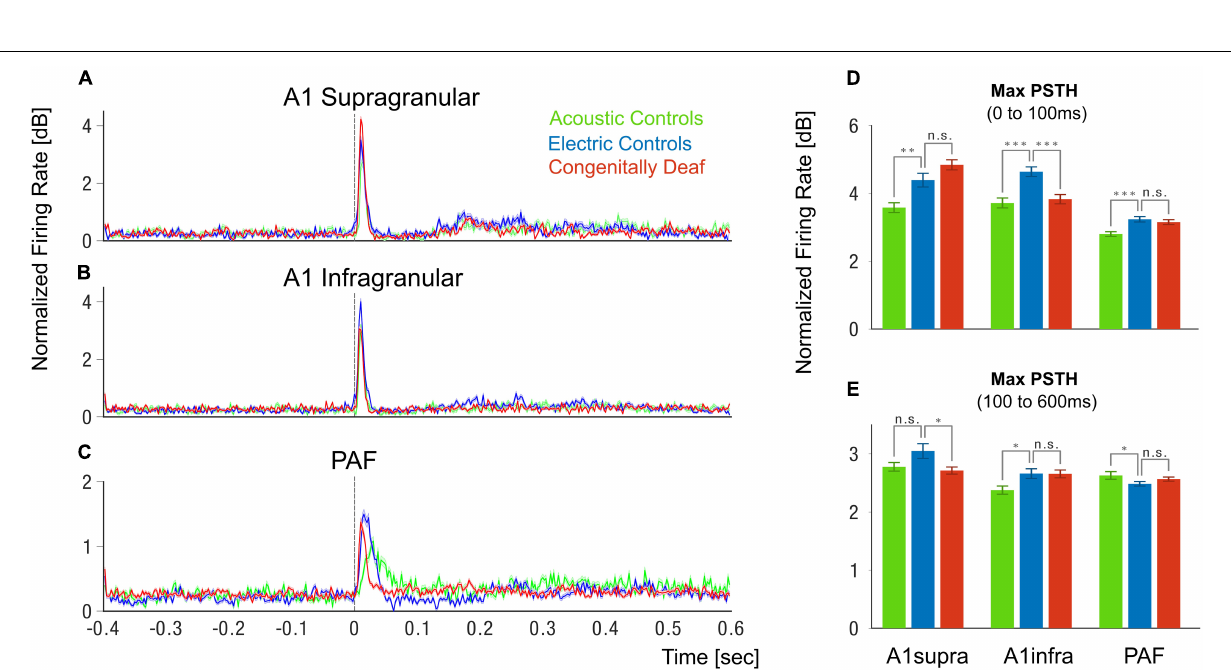
FIGURE 2 | Peristimulus histogram and spike raster plot examples. Examples of peristimulus histograms (PSTHs) (above) and spike raster plot (below) in the field A1 (A–C) and PAF (D–F) for Acoustic Controls (A,D) , Electric Controls (B,E) , and Congenitally Deaf Cats (C,F) . PSTHs are shown in spikes/millisecond, dashed red lines are showing the stimulation time point. A1 primary auditory cortex; PAF posterior auditory field.